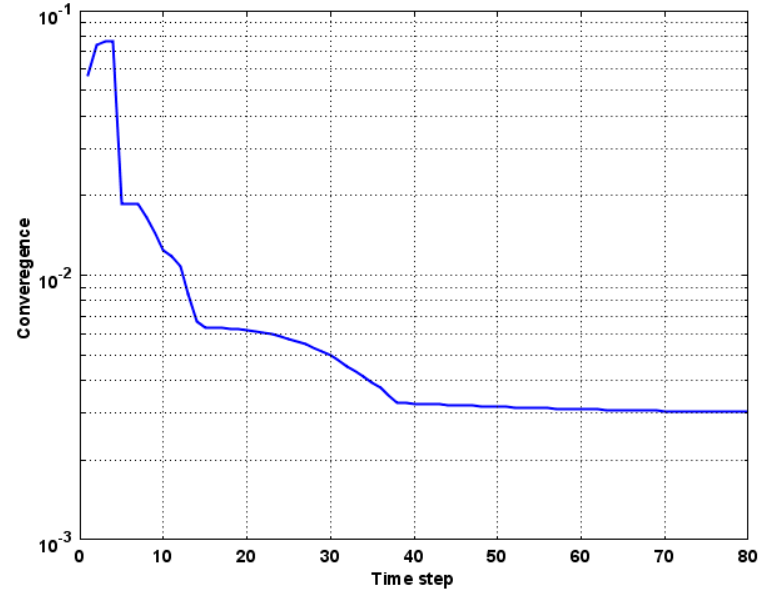
Figure 5. Convergence plot.